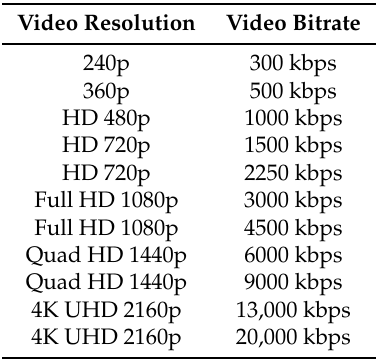
Table 1. Resolution and Bitrate